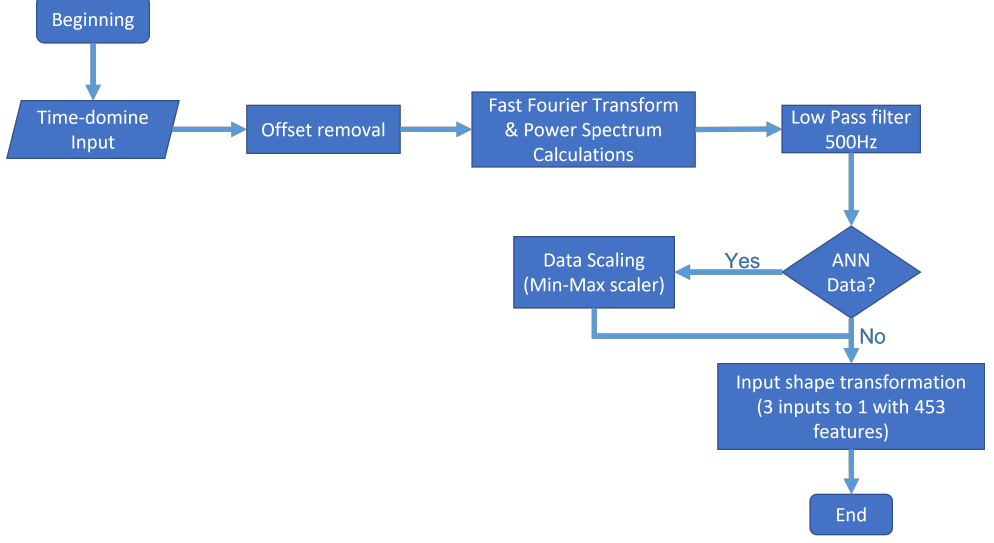
Figure 8. Data processing flow